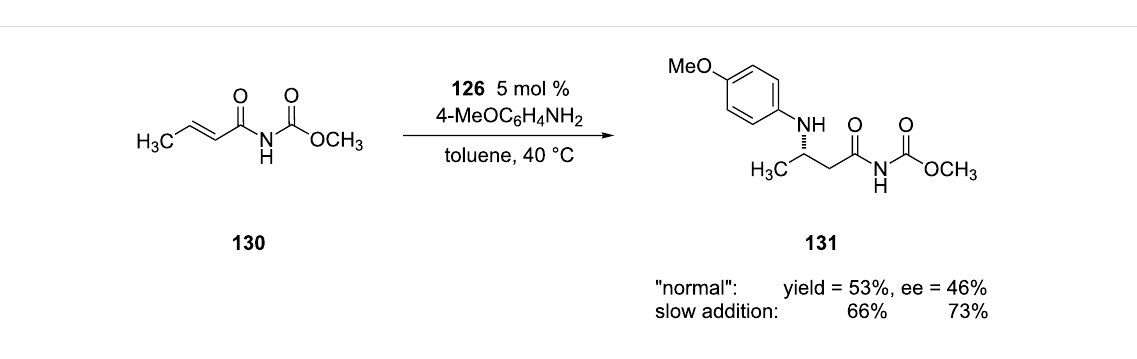
Scheme 33: Difference between aza-Michael addition ran using the standard protocol versus the slow addition